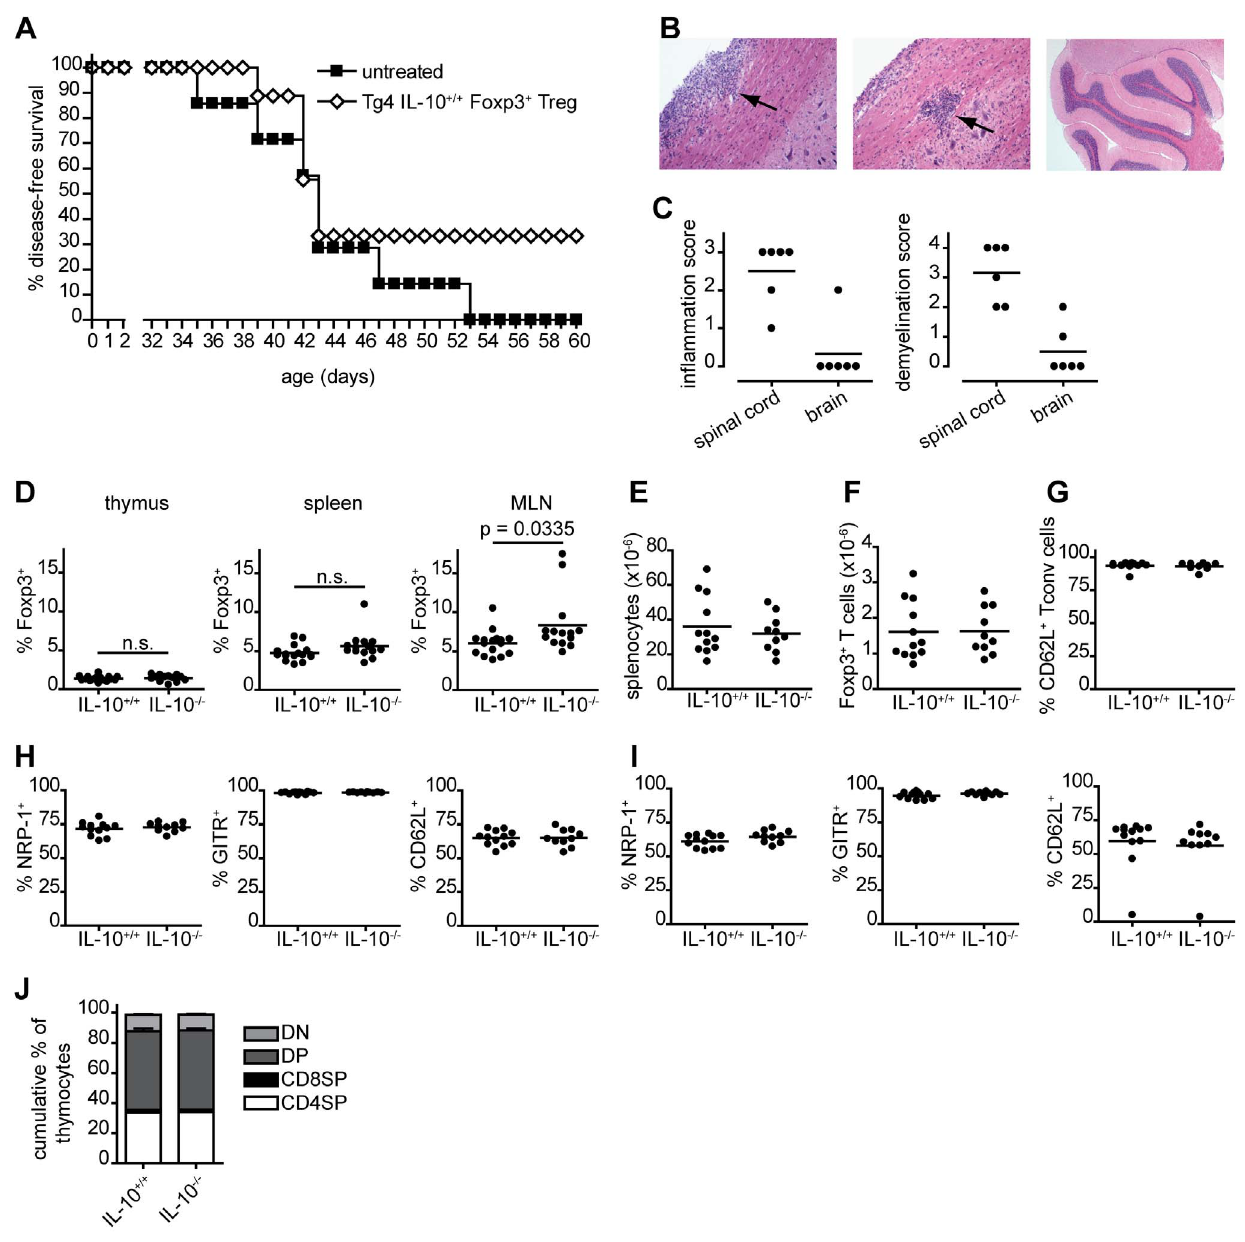
Figure 2 . Tg4 IL-10 2 / 2 mice exhibit spontaneous EAE but no deficiency in Foxp3 + Treg cell numbers or phenotype. A. Tg4 IL-10 2 / 2 mice, untreated, n=7, or receiving 1.5 6 10 6 Tg4 IL-10 + / + splenic Treg cells i.p. at age 4–5 weeks, n=9, were monitored daily for the spontaneous development of CNS autoimmune disease. Logrank test, P=0.25 B. Representative haematoxylin/eosin stained sections of spinal cord (left and middle) and brain (right) from Tg4 IL-10 2 / 2 with established CNS autoimmune disease (n=6). Arrows indicate lymphocytic infiltrate. Magnifications: left; 6 200, middle; 6 100, right; 6 25. C. Inflammation and demyelination scores of spinal cord and brain sections of Tg4 IL-10 2 / 2 with established disease. Horizontal lines indicate means. n=6 each. D-J. Tg4 IL-10 + / + and Tg4 IL-10 2 / 2 mice approximately 5 weeks of age were examined for a number of characteristics; D. Frequency of Foxp3 + cells among CD4 + CD8 2 (CD4SP) thymocytes or CD4 + T cells in the spleen and mesenteric lymph nodes (MLN). Thymus; Tg4 IL-10 + / + n=16, Tg4 IL-10 2 / 2 n=13. Spleen and MLN; Tg4 IL-10 + / + n=16, Tg4 IL-10 2 / 2 n=14. E. Total number of splenocytes. F. Number of CD4 + Foxp3 + cells in the spleen. G. Percentage CD62L expression on splenic CD4 + Foxp3 2 cells. H. Percentage Neuropilin-1 (NRP-1), GITR and CD62L expression on splenic CD4 + Foxp3 + cells. I. Percentage NRP-1, GITR and CD62L expression on CD4 + Foxp3 + cells in the MLN. J. Cumulative frequency of CD4 and CD8 single positive (SP), double positive (DP) or double negative (DN) thymocytes. E–J. Tg4 IL-10 + / + n=12, Tg4 IL- 10 2 / 2 n=10. D–I. statistical analysis by unpaired, 2-tailed, t-test. Panels E-I; no significant differences.